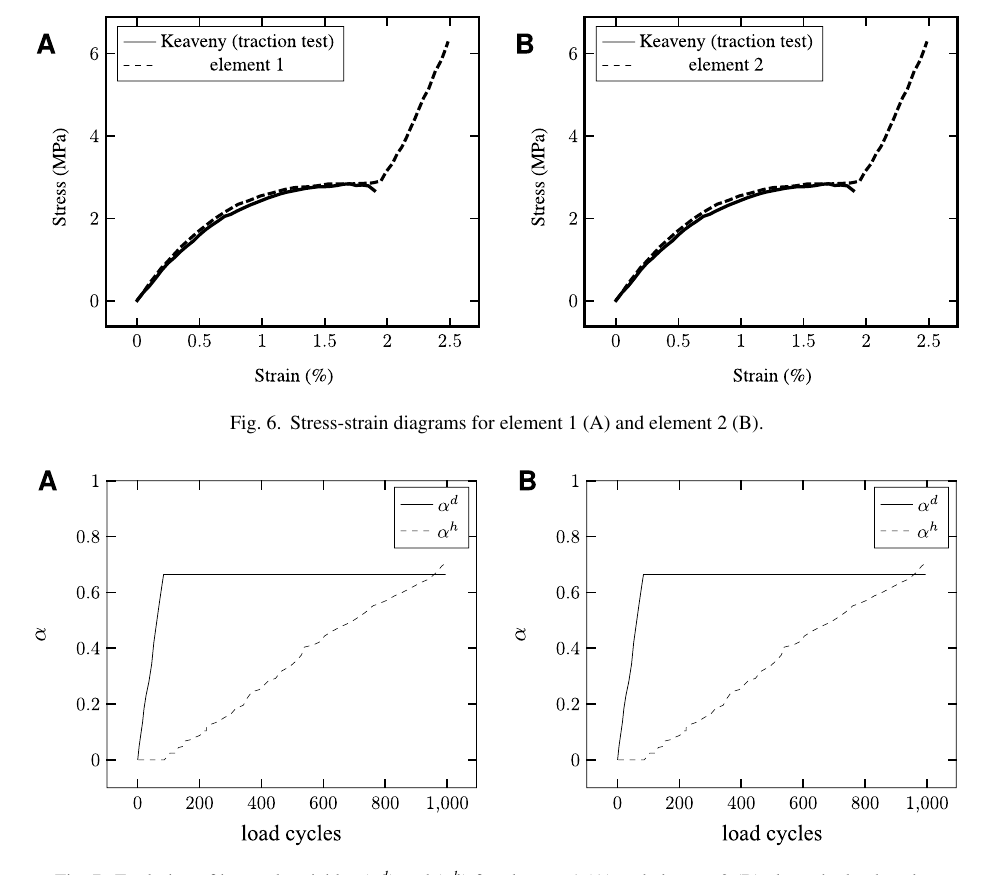
Fig. 7. Evolution of internal variables ( α d ) and ( α h ) for element 1 (A) and element 2 (B) along the load cycles.